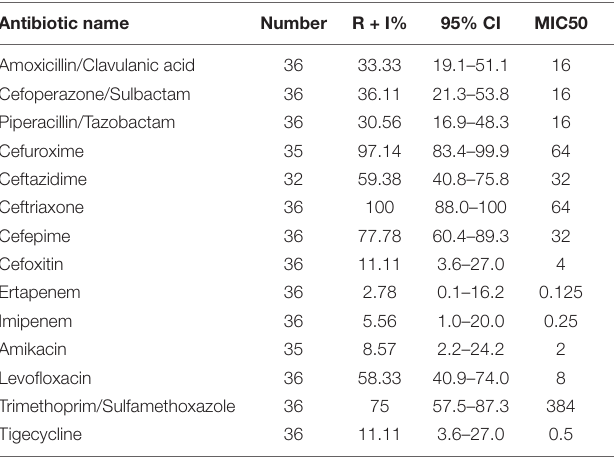
TABLE 3 | The antibiotic resistance of ESBL-positive